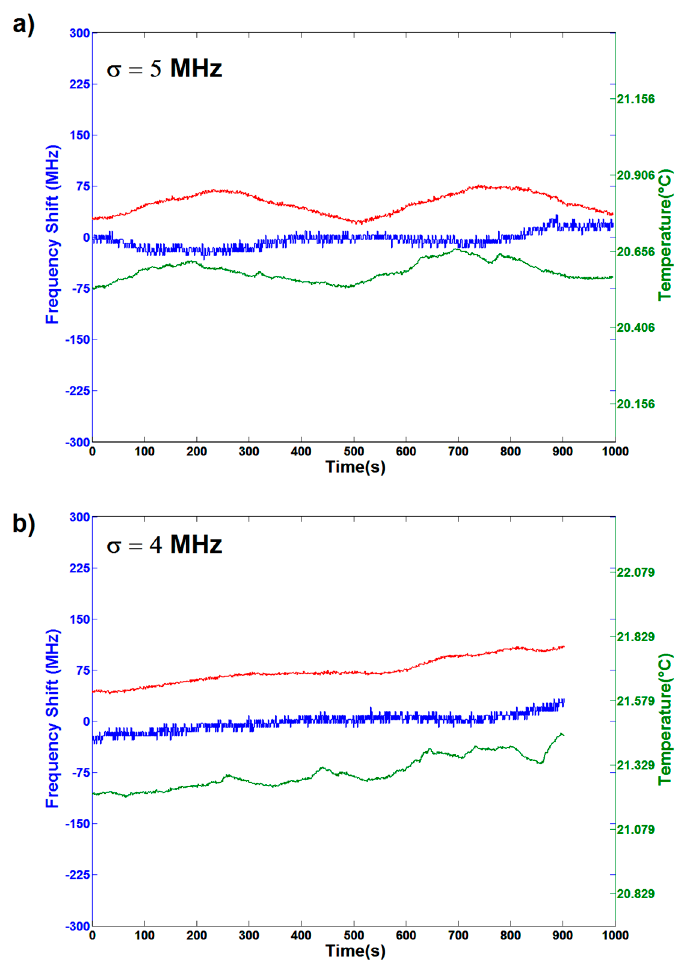
Figure 3. Resonance frequency and temperature fluctuations versus elapsed time for the OMBR system enclosed in a PMMA box in the case of air-( a ) and water-( b ) filling of the resonator. The corresponding values of σ for similar temperature oscillations are 5 MHz and 4 MHz in the case of air-filling and water-filling, respectively. A direct correlation of resonance frequency and temperature oscillation is clearly observable. Such oscillations are damped in the case of water-filling.